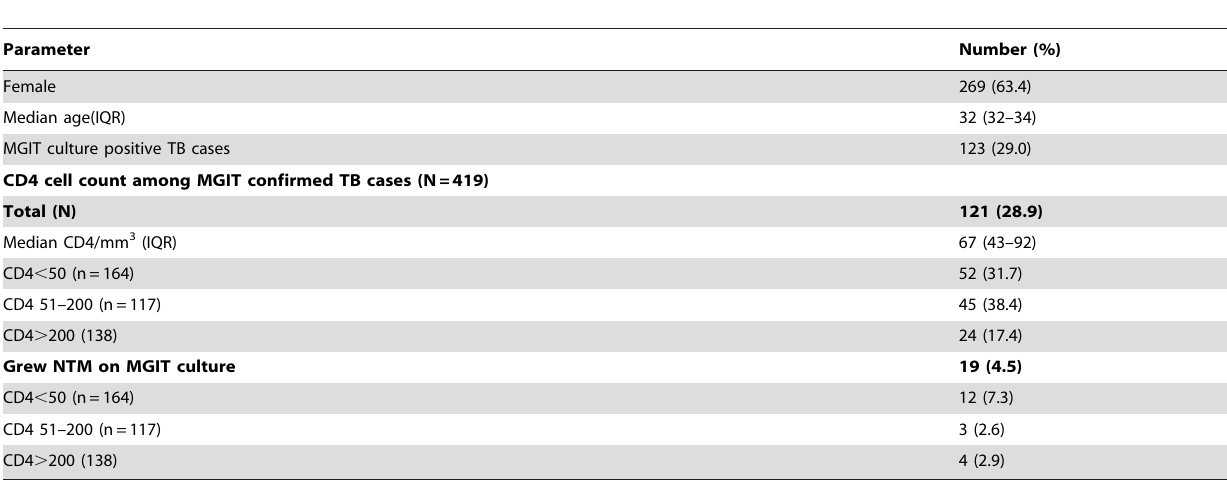
Table 1. Characteristics and CD4 cell count categories of participants enrolled (N= 424).